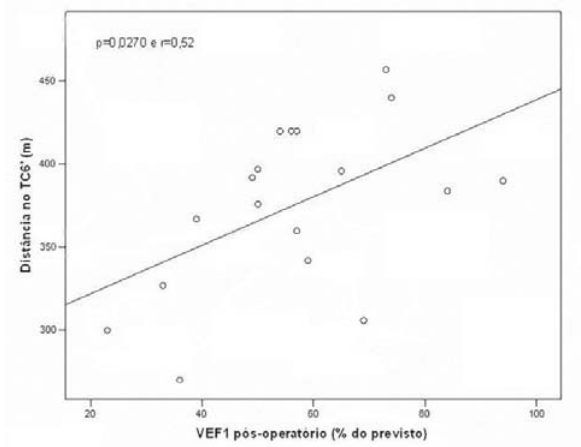
Fig. 3 - Correlação da distância no Teste de Caminhada de